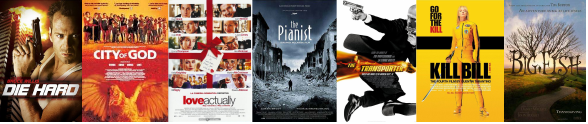
Figure 7. Examples of items in the MovieLens dataset.